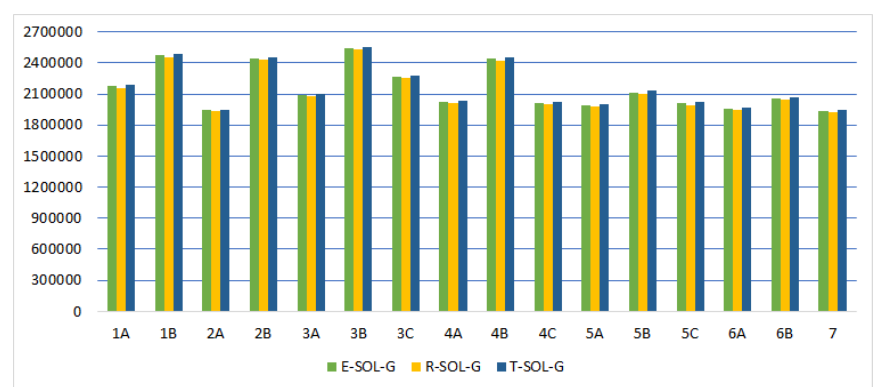
Fig. 2. Comparison of heat gain from solar radiation in 3 models